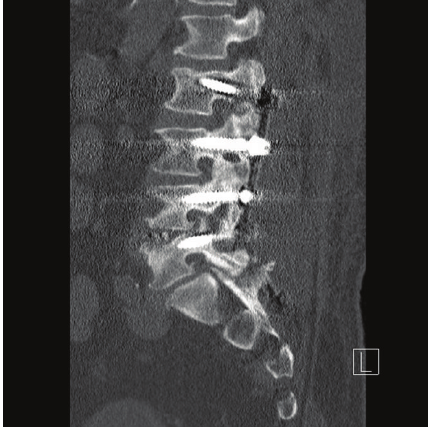
Figure 1: Sagittal view of CT scan showing loose L2 screws and a pseudarthrosis at the L2-L3 level.